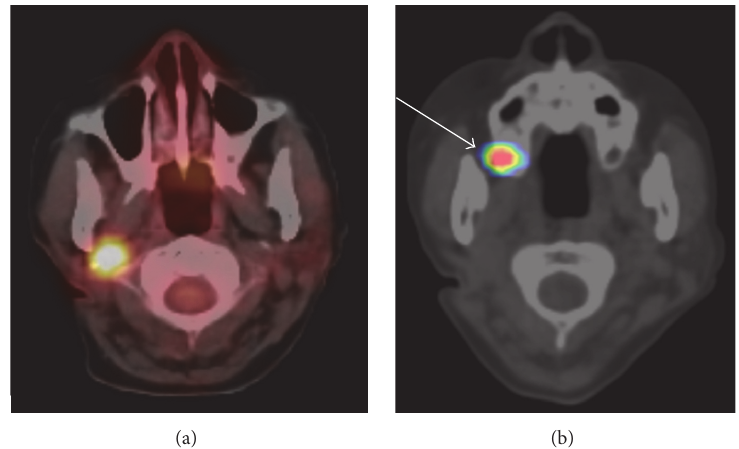
Figure 2: (a) 18 F-FDG PET/CT image: remarkable abnormal FDG uptake by the lymph node metastasis in the right parapharyngeal space. (b) 131 I SPECT/CT image obtained 7 days after a 131 I 3.7 GBq dose of RIT: 131 I uptake by the lymph node metastasis is not evident. The abnormal distribution in the right maxillary sinus (white arrow) represents 131 I secretion into the nasal